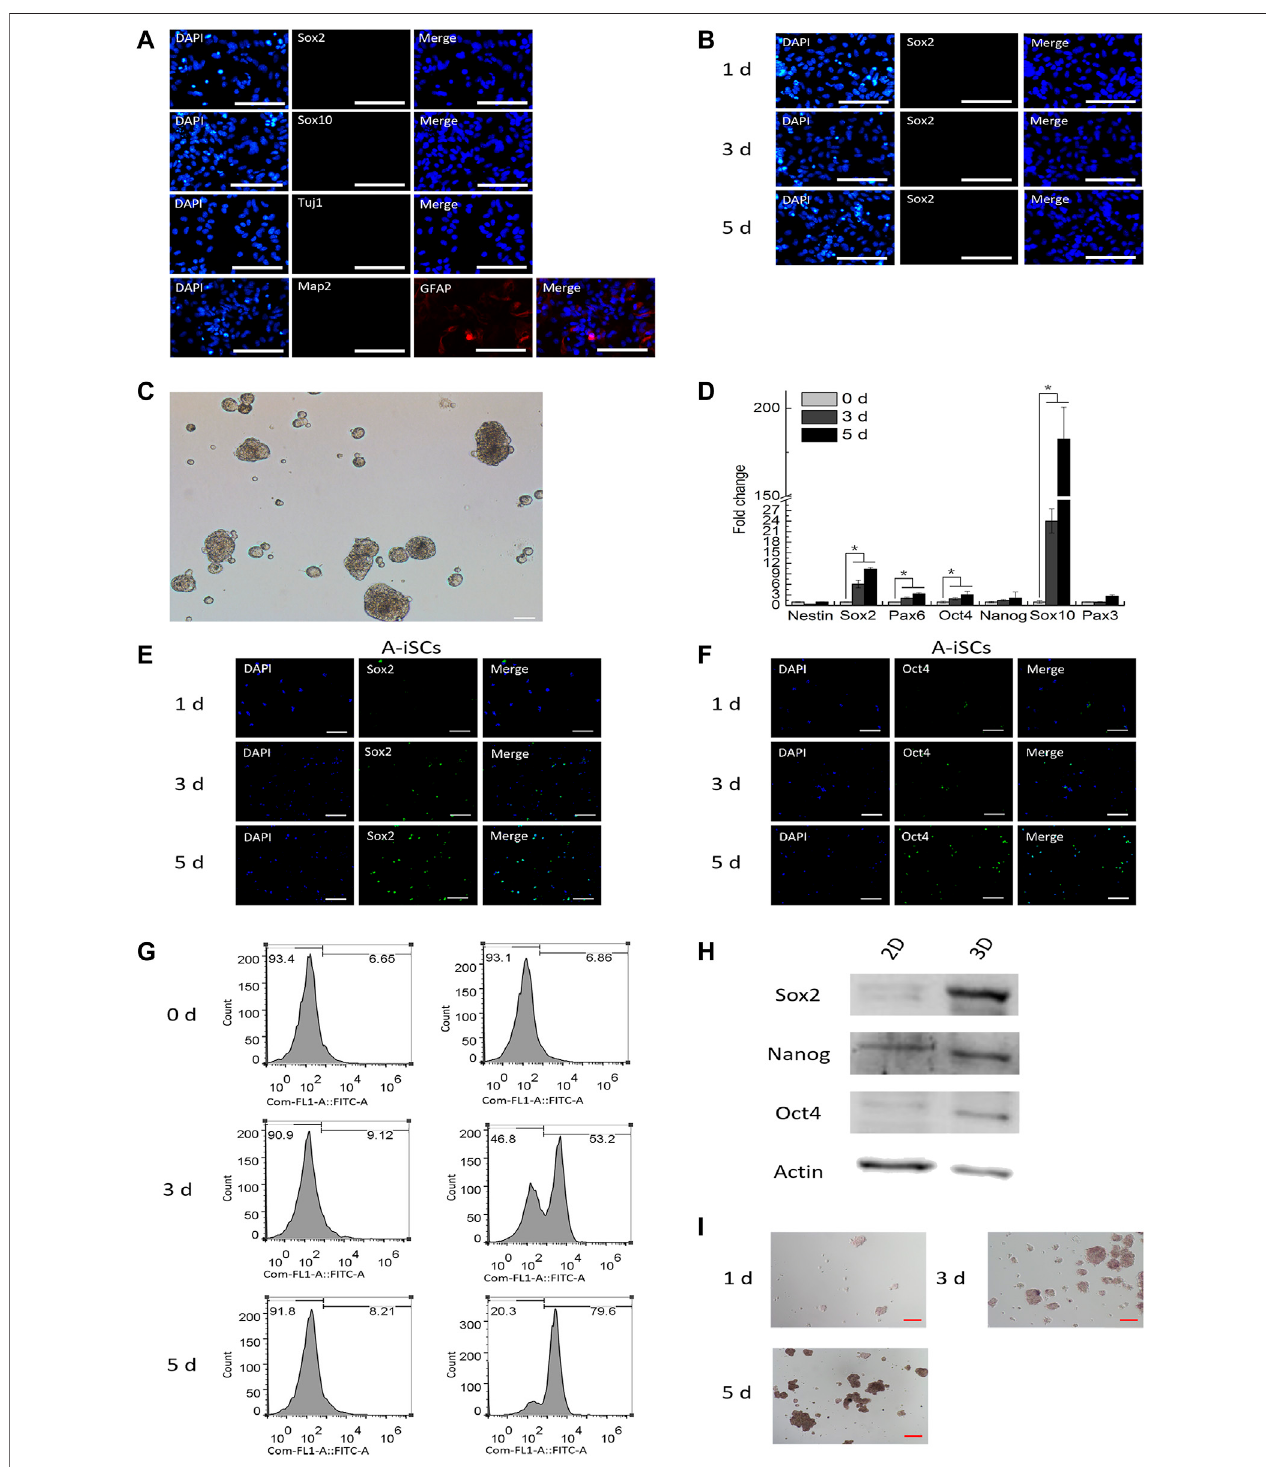
FIGURE 1 | (A) Starting mouse astrocytes were immunopositive for GFAP but negative for Sox2, Sox10, Tuj1, and Map2. Scale bar: 50 μ m. (B) Astrocytes in 2D culture were immuno-negative for Sox2. Scale bar: 50 μ m. (C) Mouse astrocytes formed 3D spheres within 24 h on agarose surfaces. Scale bar: 50 μ m. (D) RT-PCR analysisofstemcell-speci fi cgenesinmouseastrocytesin3Dspheresovertime. (E) ExpressionofSox2inmouseastrocytes in3Dspheresovertime.Scalebar:50 μ m. (F Expression of Oct4 in mouse astrocytes in 3D spheres over time. Scale bar: 50 μ m. (G) Expression ofSox2 in mouse astrocytes in 3D spheres( fl ow cytometry). (H) Western blotting of stem-speci fi c markers in 2D- and 3D-cultured astrocytes. (I) Alkaline phosphatase staining for mouse astrocytes in 3D spheres over time. Scale bar: 50 μ m.